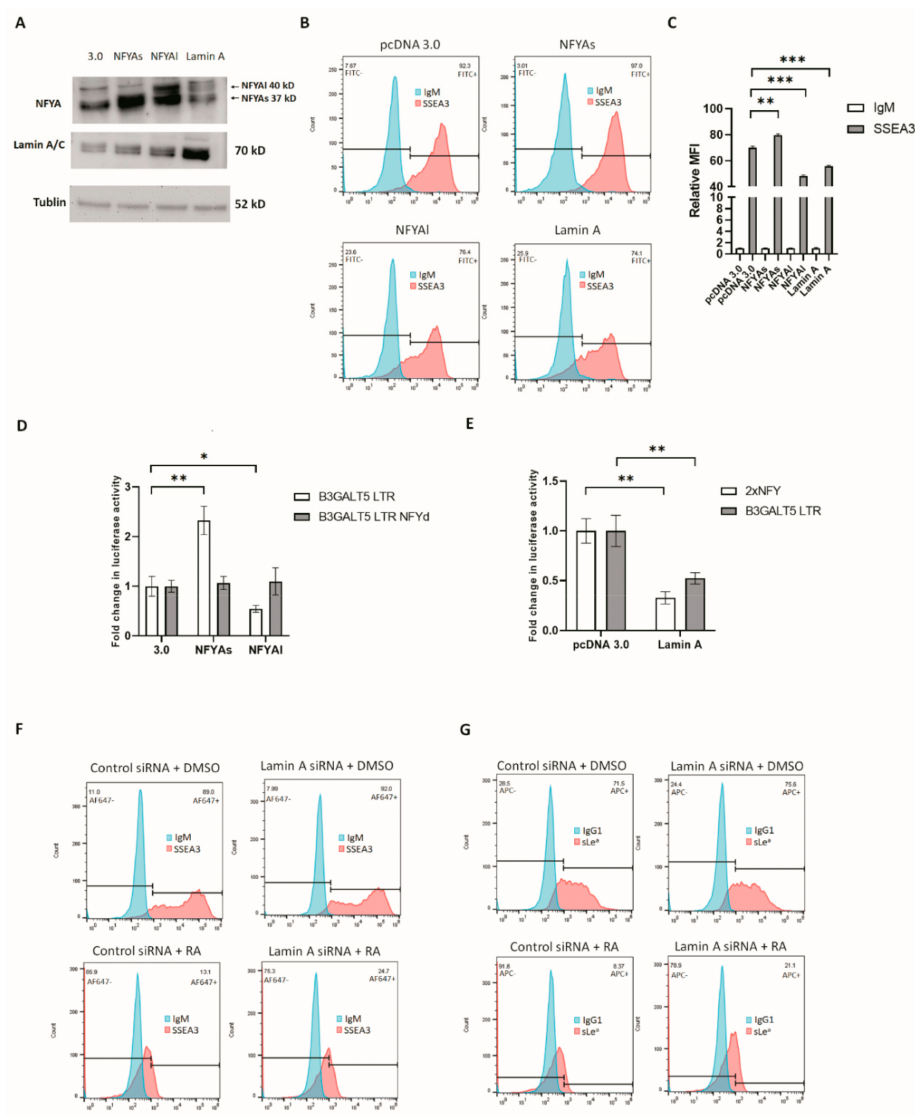
Figure 5. NFYAs, NFYAl, and lamin A regulate SSEA3 synthesis in 2102Ep cells. ( A ) NFYAs, NFYAl, and lamin A were detected by western blotting. Tubulin served as the loading control. ( B ) Flow cytometry showing the levels of SSEA3 on 2102Ep cells after transfection with pcDNA 3.0 or a pcDNA 3.0 containing an NFYAl, NFYAs, or lamin A sequence. ( C ) The MFI of stained SSEA3 compared